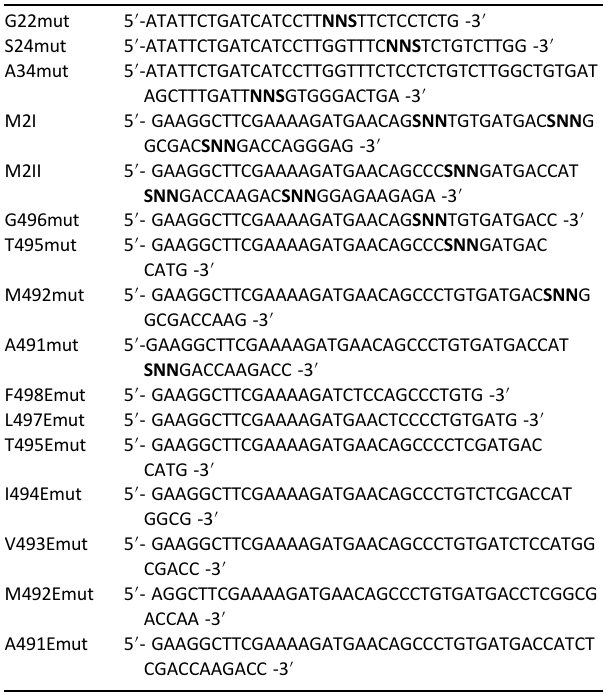
Table 1 . PCR primers used to create CD39 mutations. Primer sequence from 5 ′ to 3 ′